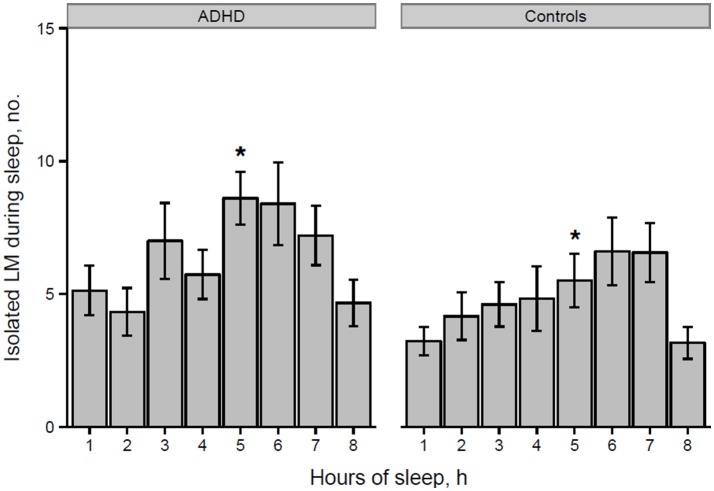
Number of isolated LMs per hour of sleep in participants with ADHD and controls (*p = 0.028 at hour 5 of sleep). *p < 0.05.